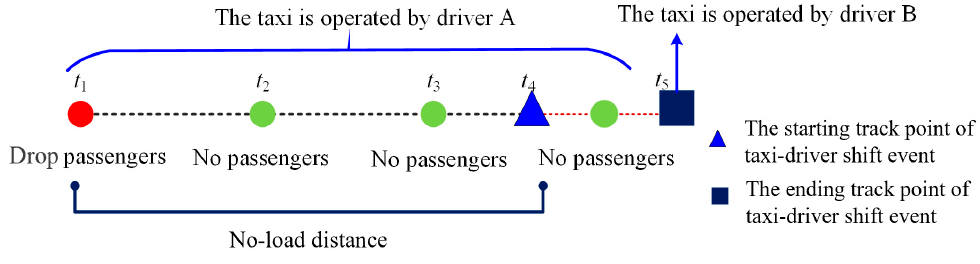
Figure 4. Schematic diagram of a taxi-driver shift behavior.